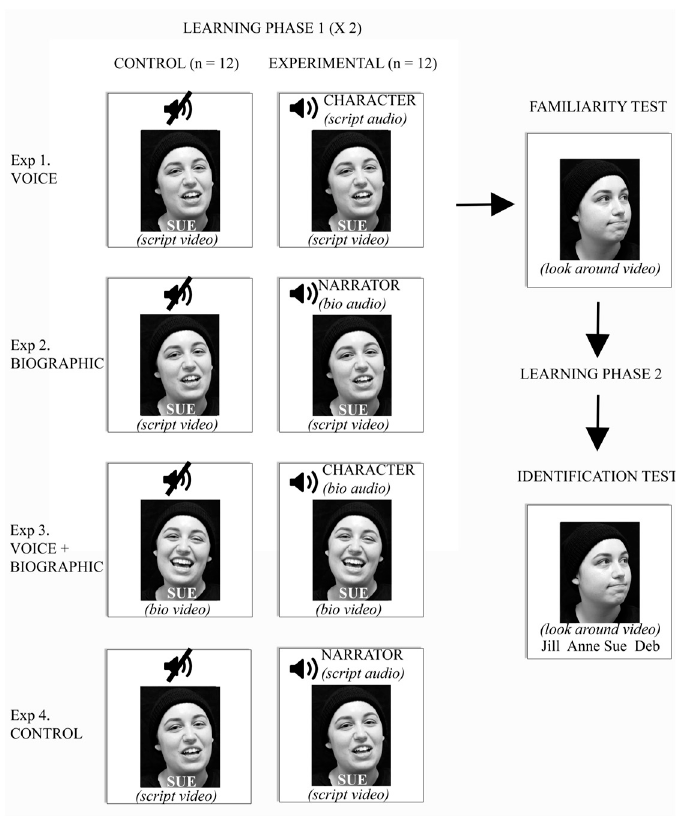
Figure 1. Methods. The learning phases for the four different experiments are shown on the left, with each row showing the control (face/name only) and experimental (multi-modal) conditions. Each box depicts the audio and visual components in each trial. If there was an audio-clip, either a narrator or the character could be talking, and relating either a generic script or specific biographic data (‘bio’) about the character. The video-portion of the clip (labeled below) could show the character’s face as they read the script or were giving their biographic data. After two cycles of learning, subjects then had a familiarity test, using different silent videos, of the character looking around. This was followed by a second learning phase of one cycle. The final phase was testing identification, by matching the silent ‘looking around’ face to the correct name in an array of four choices shown below the face.